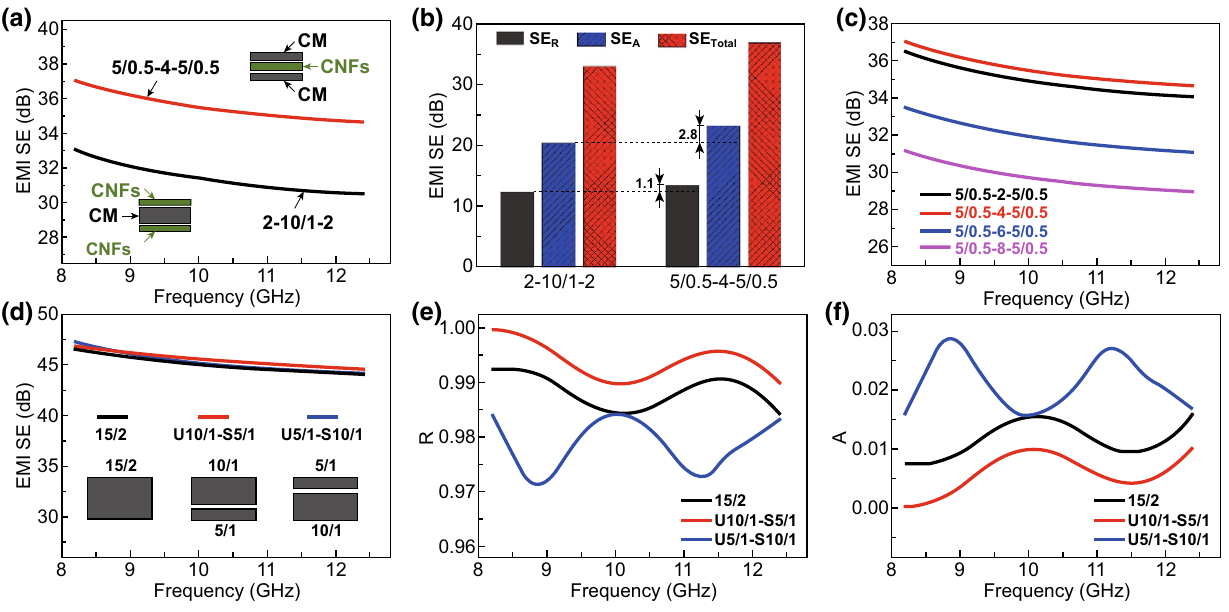
Fig. 5 a EMI SE of composite paper with different sandwich structures in the X‑band. b Comparison of SE Total , SE A , and SE R of composite paper with different sandwich structures. c The EMI SE of CM–CNFs–CM composite paper with various CNFs contents in the X‑band. The d EMI SE, e R , and f A of evenly distributed CM composite paper and two‑layered CM composite paper with different gradient structures in